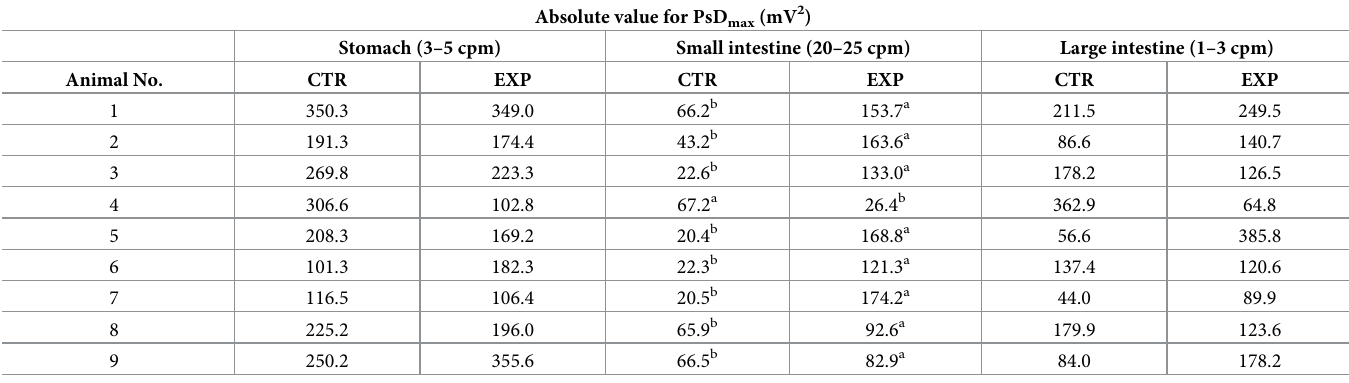
Values with different superscripts differ at P � 0.001.